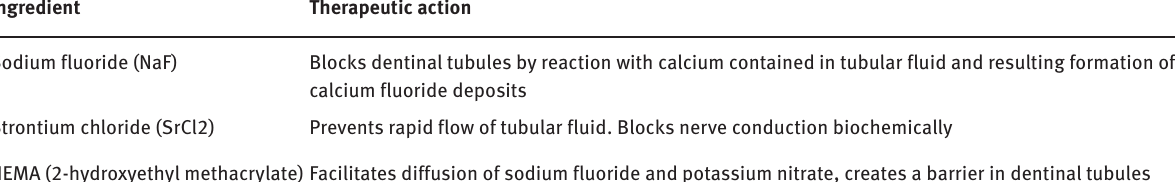
Table 1: Therapeutic action of selected ingredients of dentinal desensitizing preparations Ingredient Therapeutic action Sodium fluoride